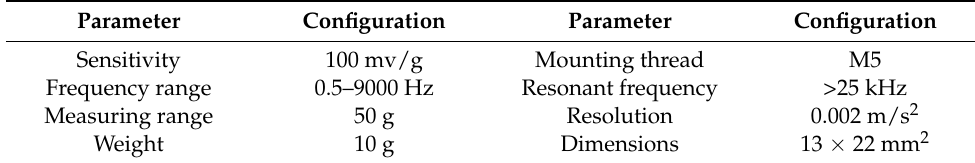
Figure 10. INV3062V 24-bit network-distributed acquisition instrument. Table 11. Acceleration sensor parameters. Table 11. Acceleration sensor parameters.